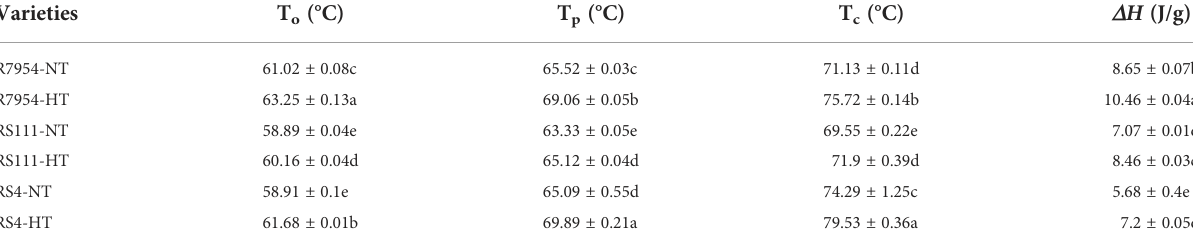
TABLE 4 Thermal properties of R7954, RS111, and RS4 at NT and HT*.